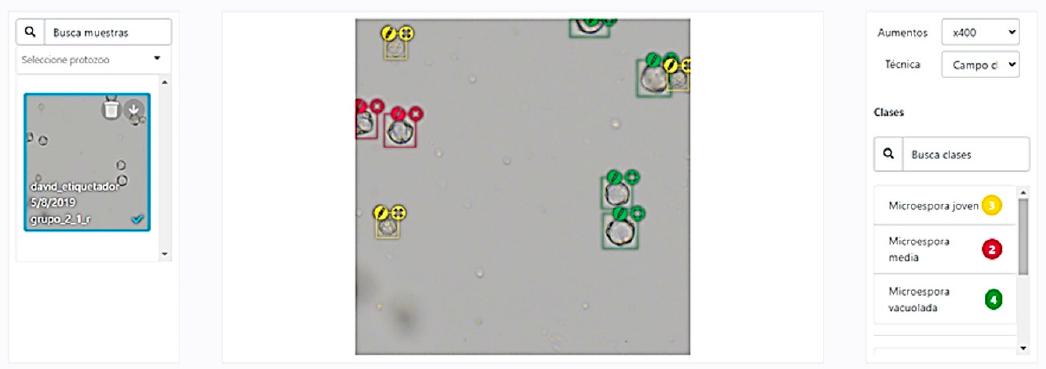
Figure 3 . Graphic environment of the manual labelling software used for the classification of the microspores that was used for the Microscan model training. In the central part it can be seen how the cells have been labelled by an expert and classified according to their stage of development.